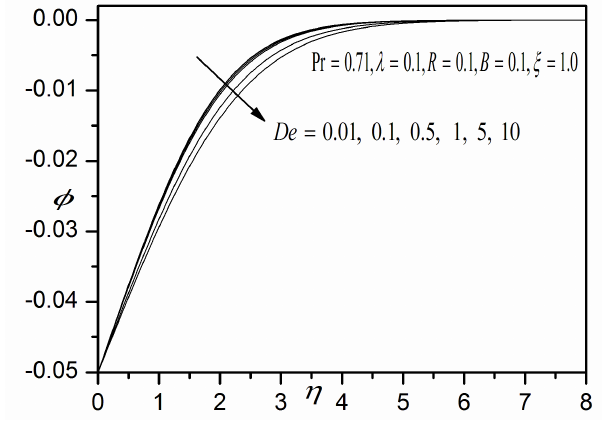
Fig. 4: Influence of De on the angular